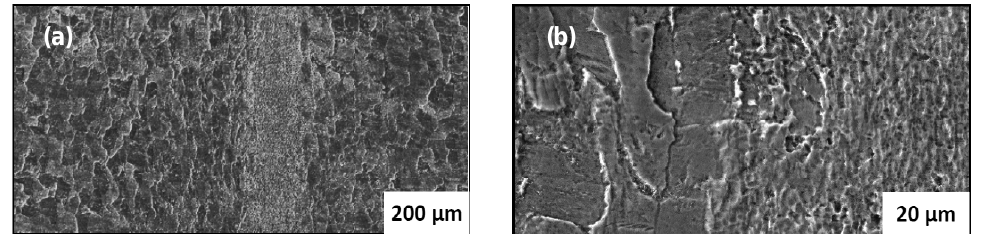
Fig. 5. SEM micrograph of welding zone of coarse-grained titanium: (a) general view; (b) details of transition